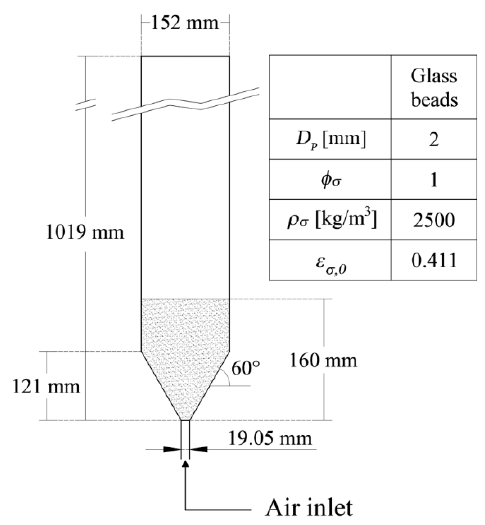
Figure 1. Details of the experimental setup for the cases with H σ ,0 = 160 mm.